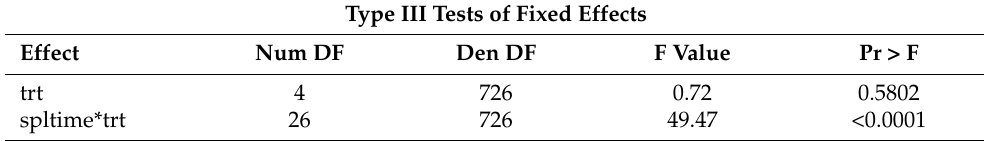
Table A1. Test of Fixed Effects for germination.